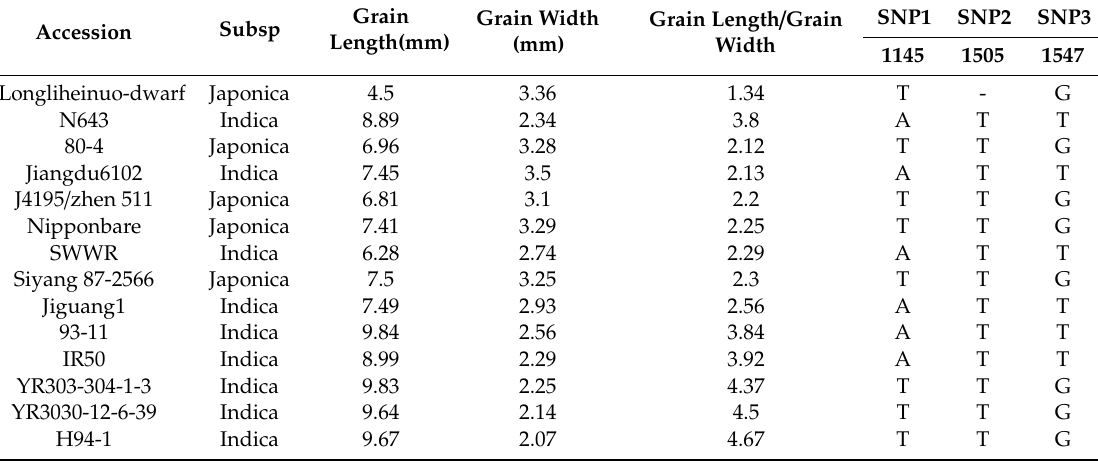
Table 3. SNP diversity analysis for qGS7